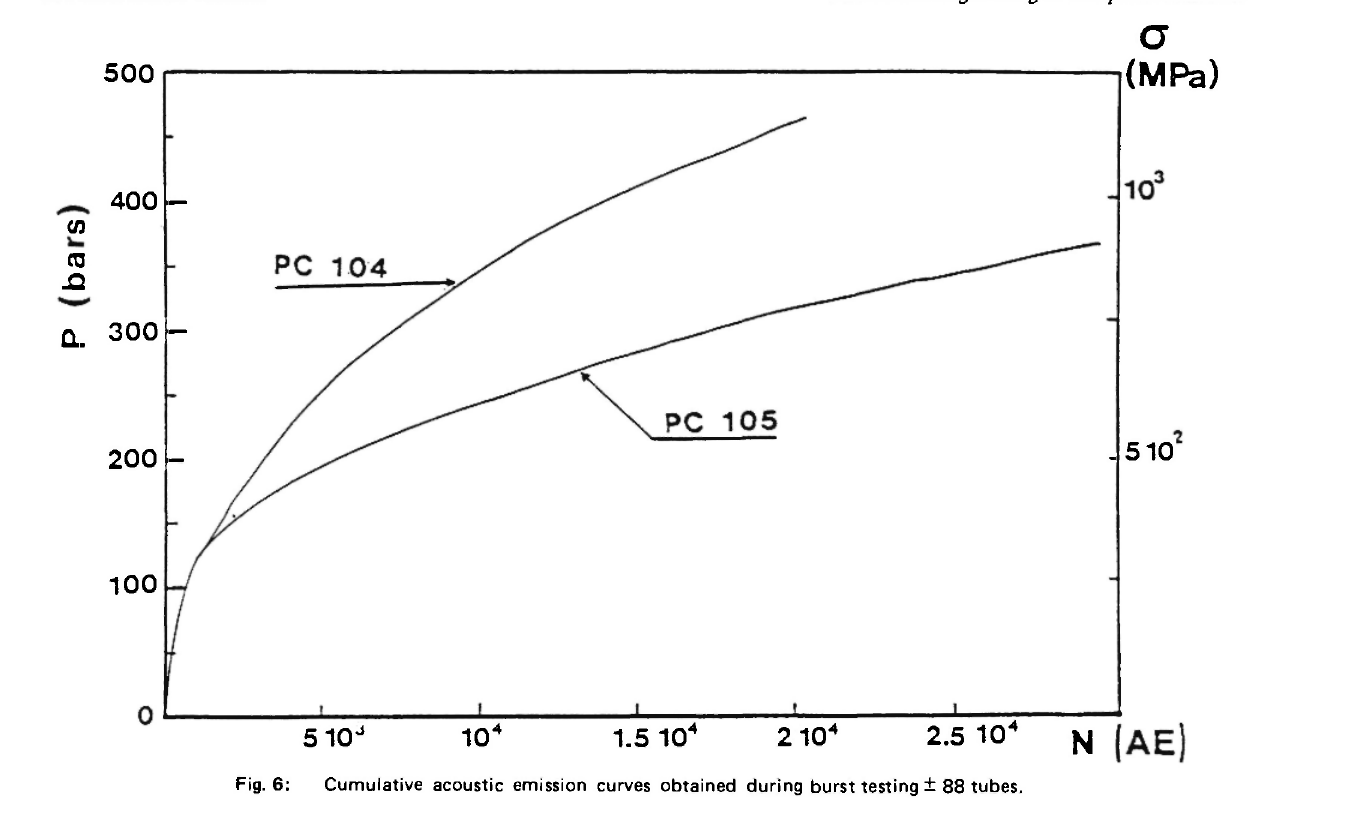
Fig. 6; Cumulative acoustic emission curves obtained during burst testing ± 88